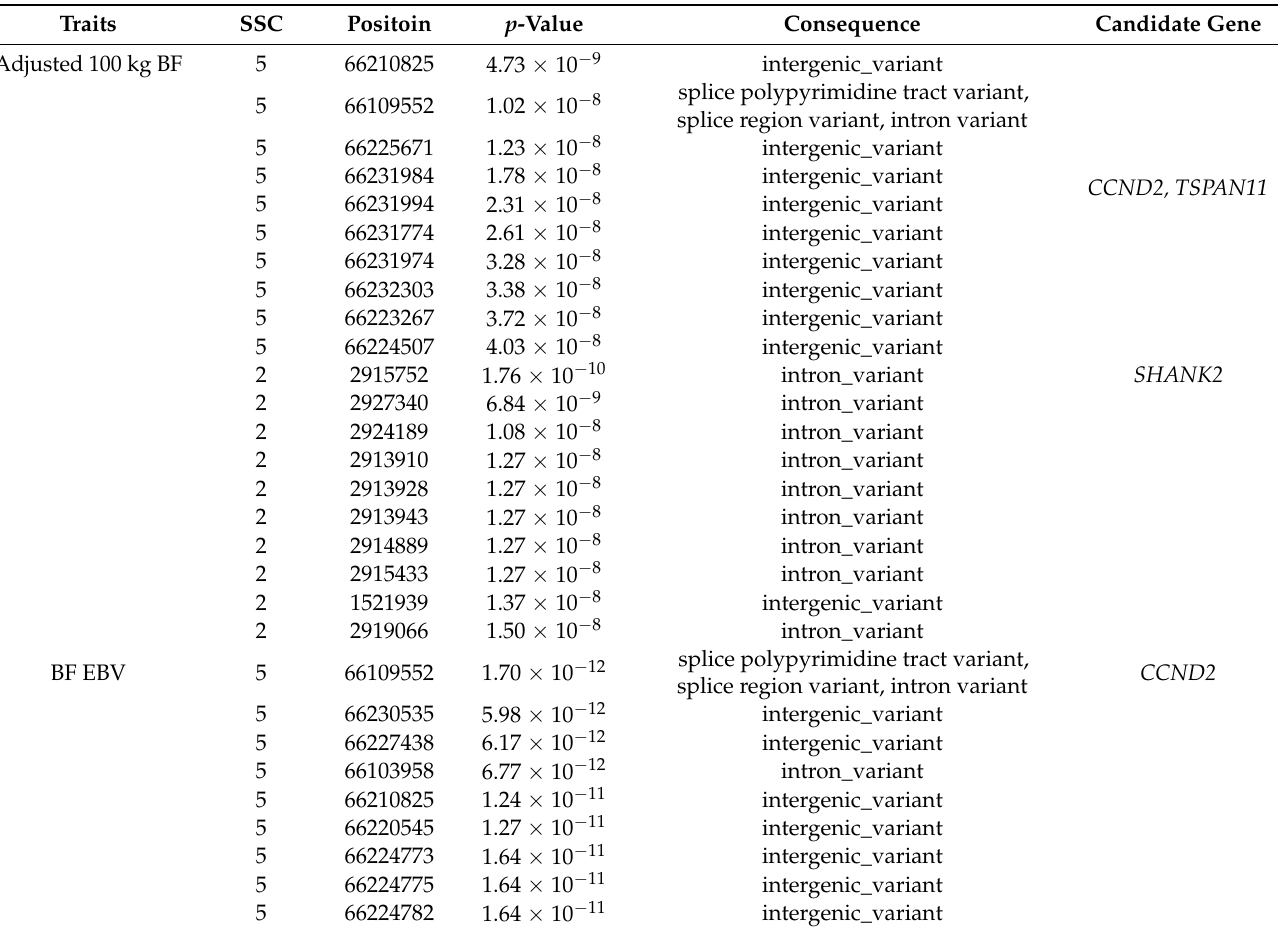
Table 2. Top 10 significant SNPs and genes associated with BF traits in the QTL intervals identified by 2-LOD drop